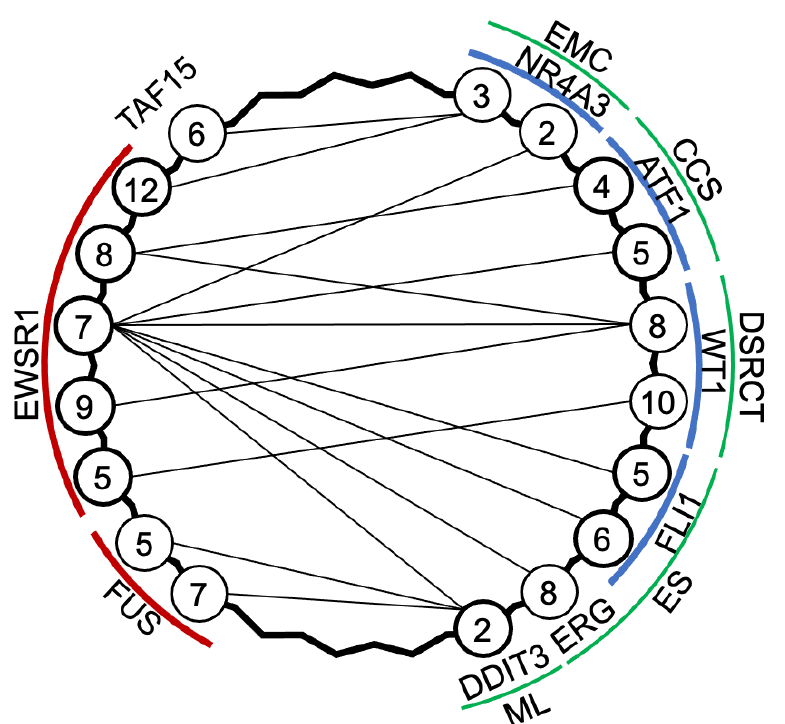
Figure 2. Translocation partners in EWSR1-associated sarcomas. Extraskeletal mxyoid chondrosarcoma (EMC) [64 – 66], clear cell sarcoma (CCS) [67], desmoplastic small round cell tumour (DSRCT) [68] , Ewing’s sarcoma (ES) [69], and myxoid liposarcoma (ML) [70,71] have common variants, which are driven by genes EWSR1 , FUS , TAF15 fused to NR4A3 , ATF1 , WT1 , FLI1 , ERG, or DDIT3 ; numbers refer to exons adjacent to the mRNA